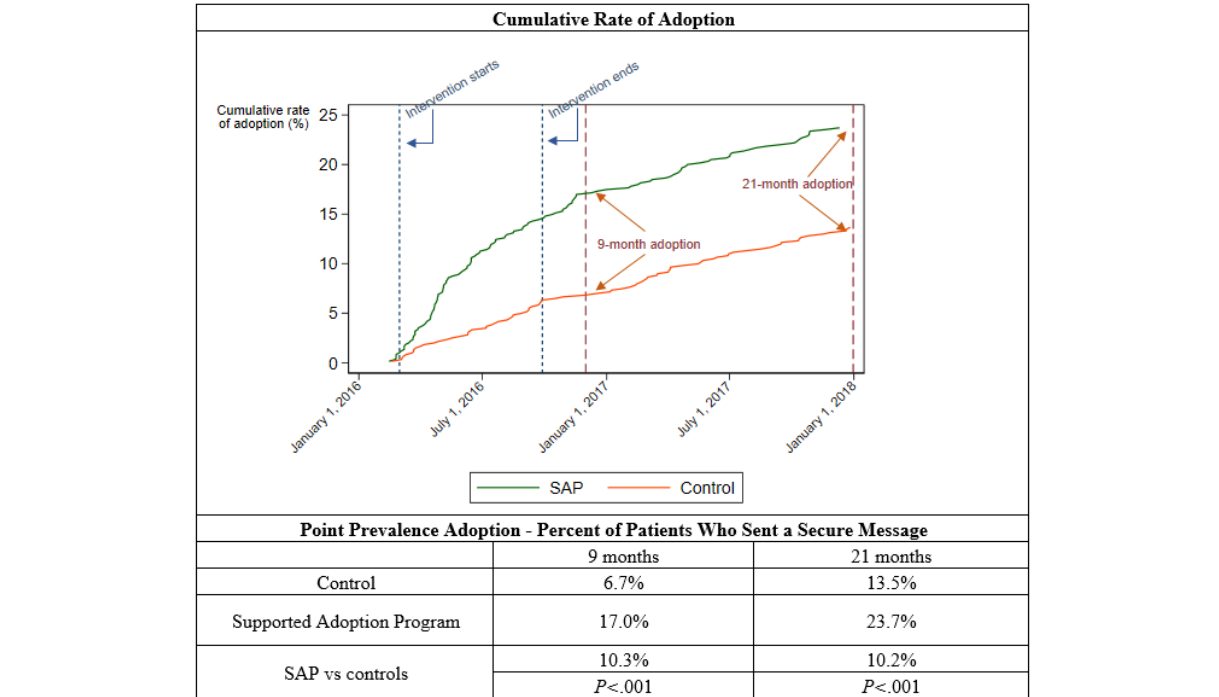
Figure 2. Cumulative rate and point prevalence of secure message adoption among those randomized to the Supported Adoption Program (SAP) and controls.